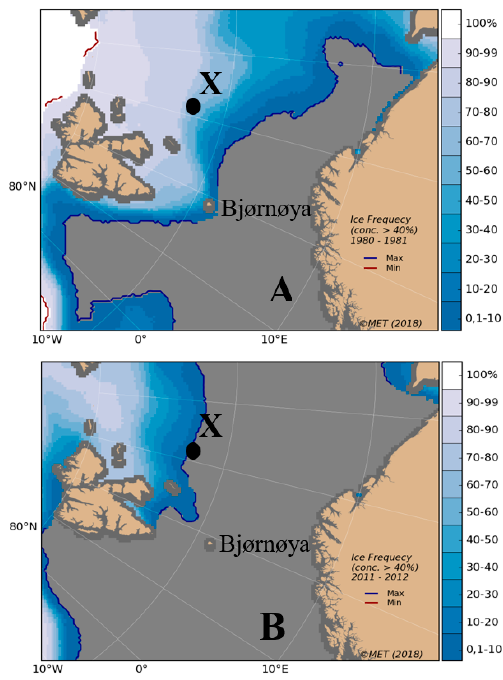
Figure 10. Frequency of 40% sea ice concentration in the western and central Barents Sea. ( A ) October 1980 to May 1981; and ( B ) October 2011 to May